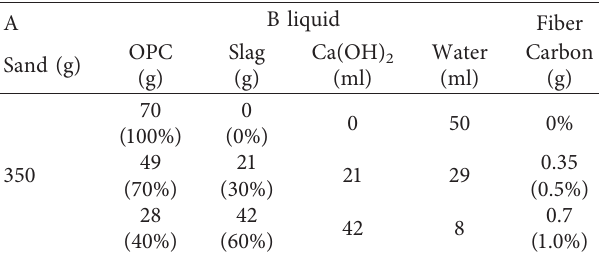
Table 3: Mixing ratio for measurement of uniaxial compression strength of grout materials using carbon